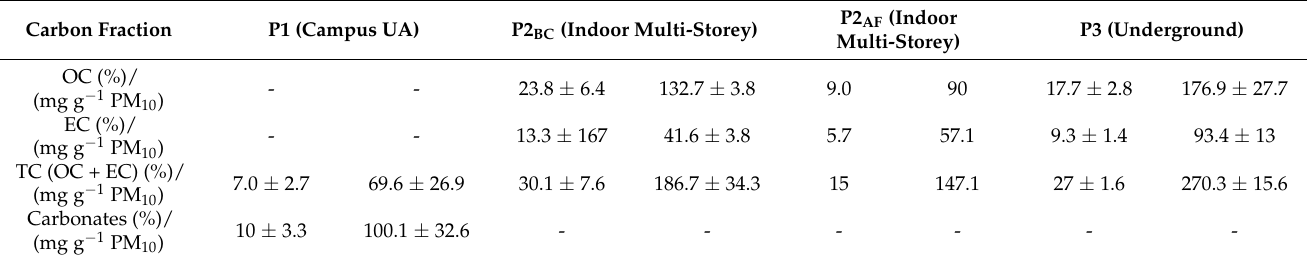
Table 1. Carbon content in percentage and PM 10 mass